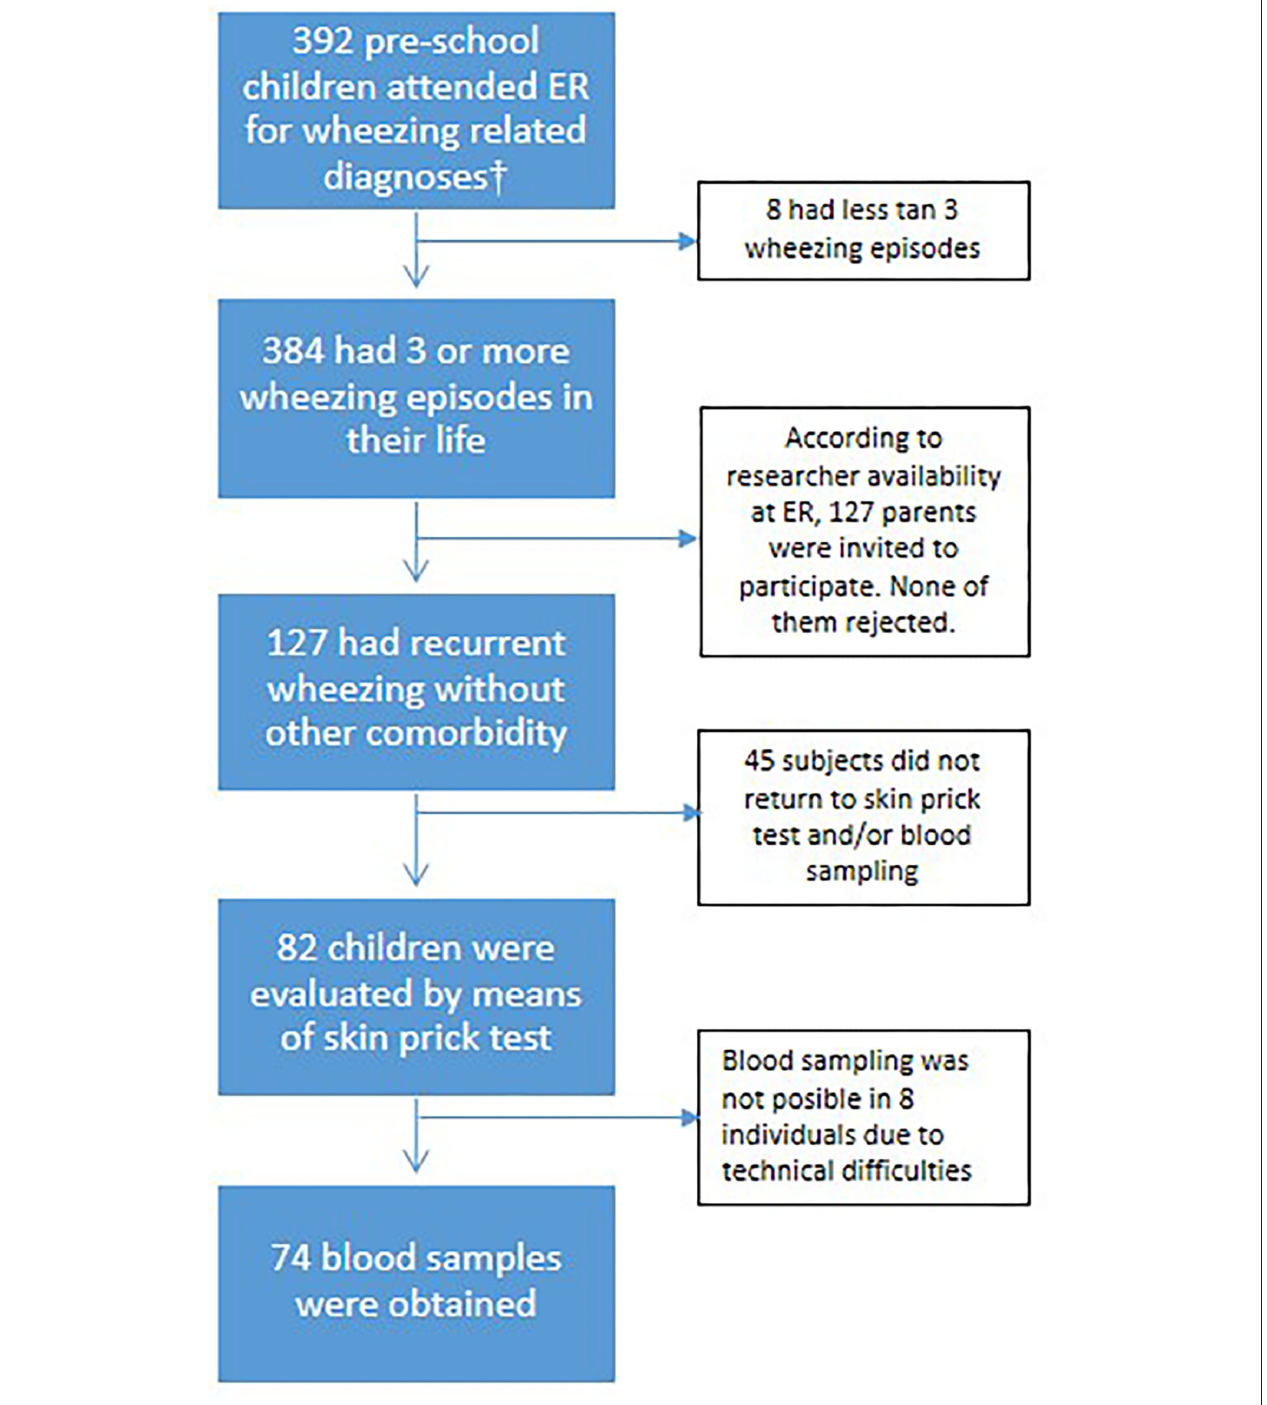
FIGURE 1 | Flowchart of participant’s selection process. † The admission codes according to the International Statistical Classification of Diseases and Related Health Problems (ICD-10) were: J40X, J42X, J441, J450, J451, J458, J459, J46X, and